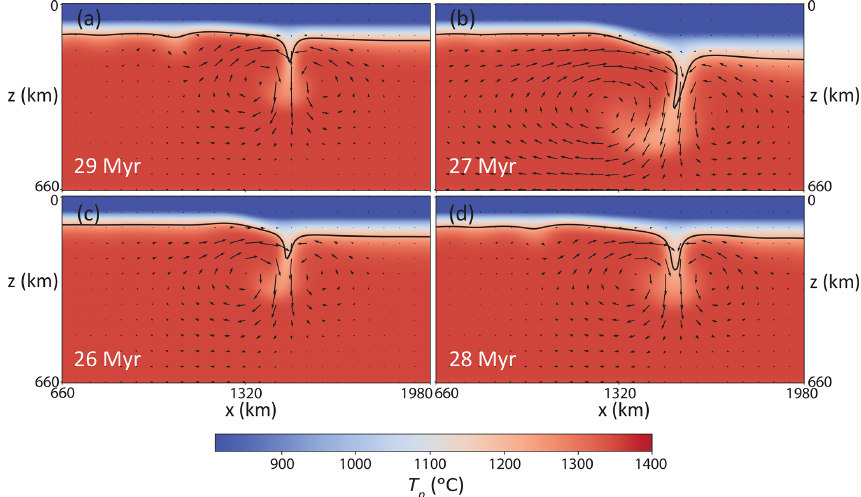
Figure 7. Effects of edge geometry on edge-driven convection, shown by snapshots of potential temperature. (a) τ c = 70Ma. (b) τ c = 150Ma. (c) w = 132km. (d) w = 396km. All other parameters as in the reference case. Note that no melting occurs in any of the models. For clarity, note that the values of the reference case are τ c = 100Ma and w =